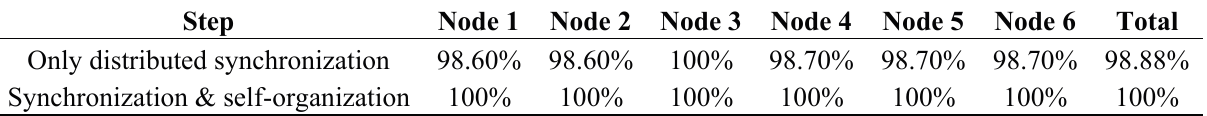
Table 3. Synchronization success probability of the proposed technique in the multi-hop mesh